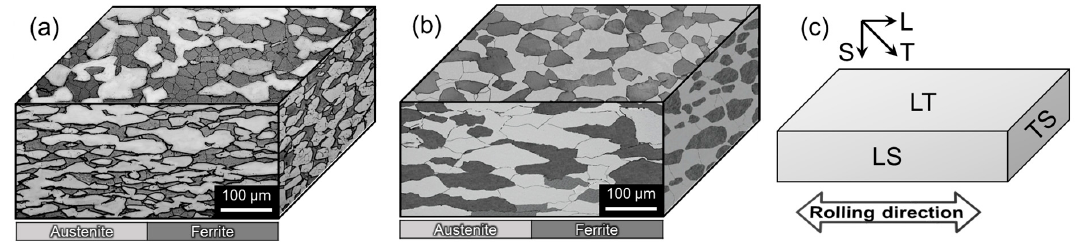
Figure 3. Three-dimensional optical micrographs of ( a ) D1 and ( b ) D2 alloys; ( c ) Definitions of the planes, LT, LS, and TS.